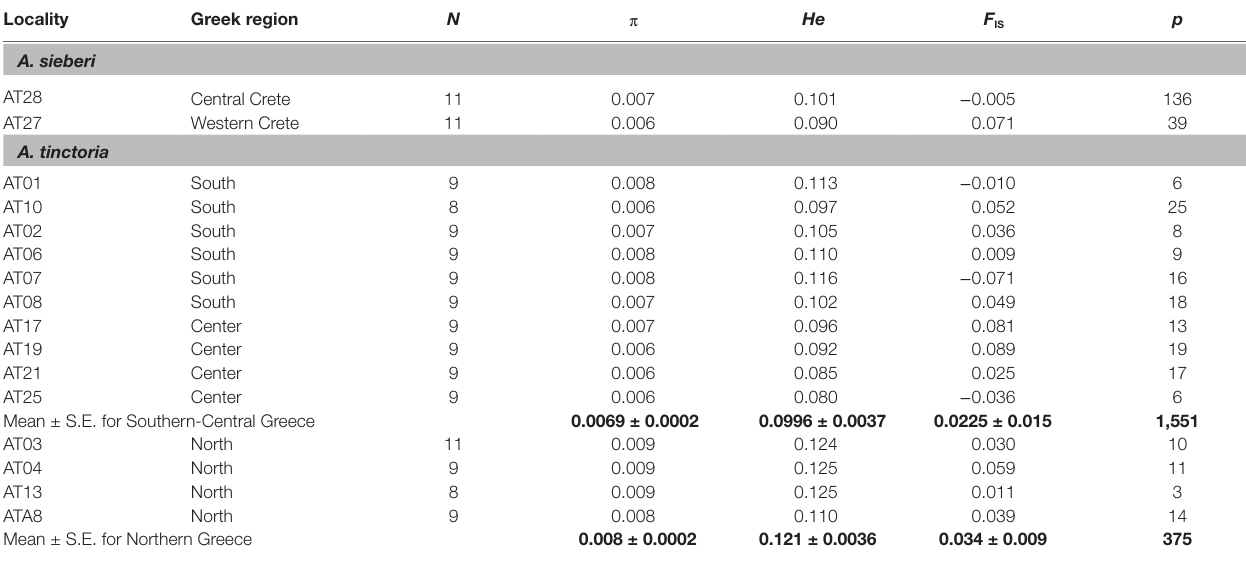
TABLE 2 | Genomic diversity in Alkanna populations.